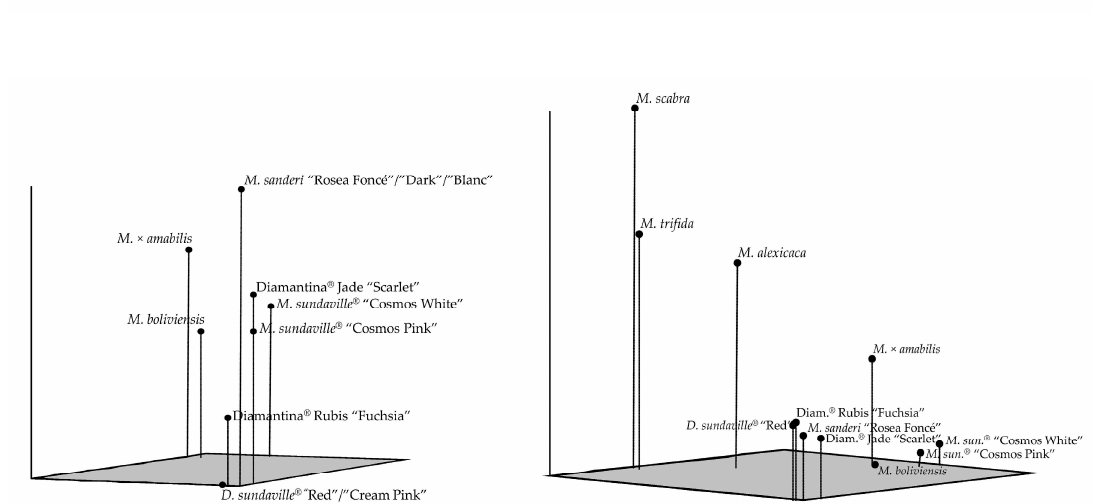
Figure 3. Principal Coordinates Analysis (PCoA) of the pairwise similarity matrix after amplification with 20 SSRs of ( a ) 11 Mandevilla cultivars and ( b ) 14 Mandevilla genotypes.